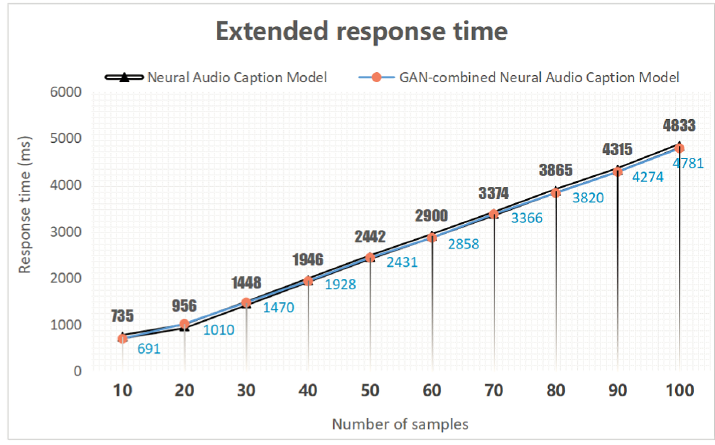
Figure 7. Scalability evaluation for NACM and